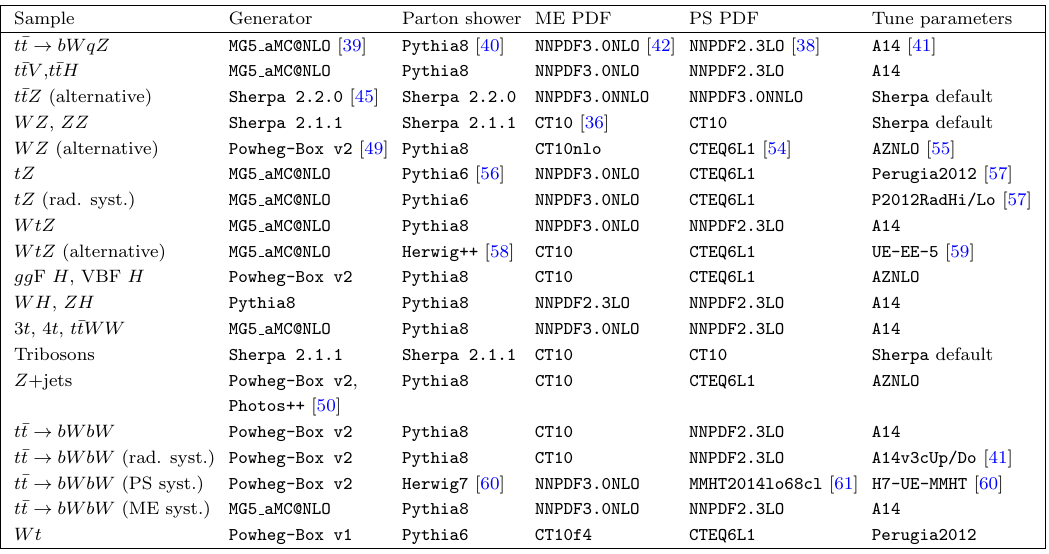
Table 2 . Generators, parton shower simulation, parton distribution functions, and tune parameters used to produce simulated samples for this analysis. The acronyms ME and PS stand for matrix element and parton shower,